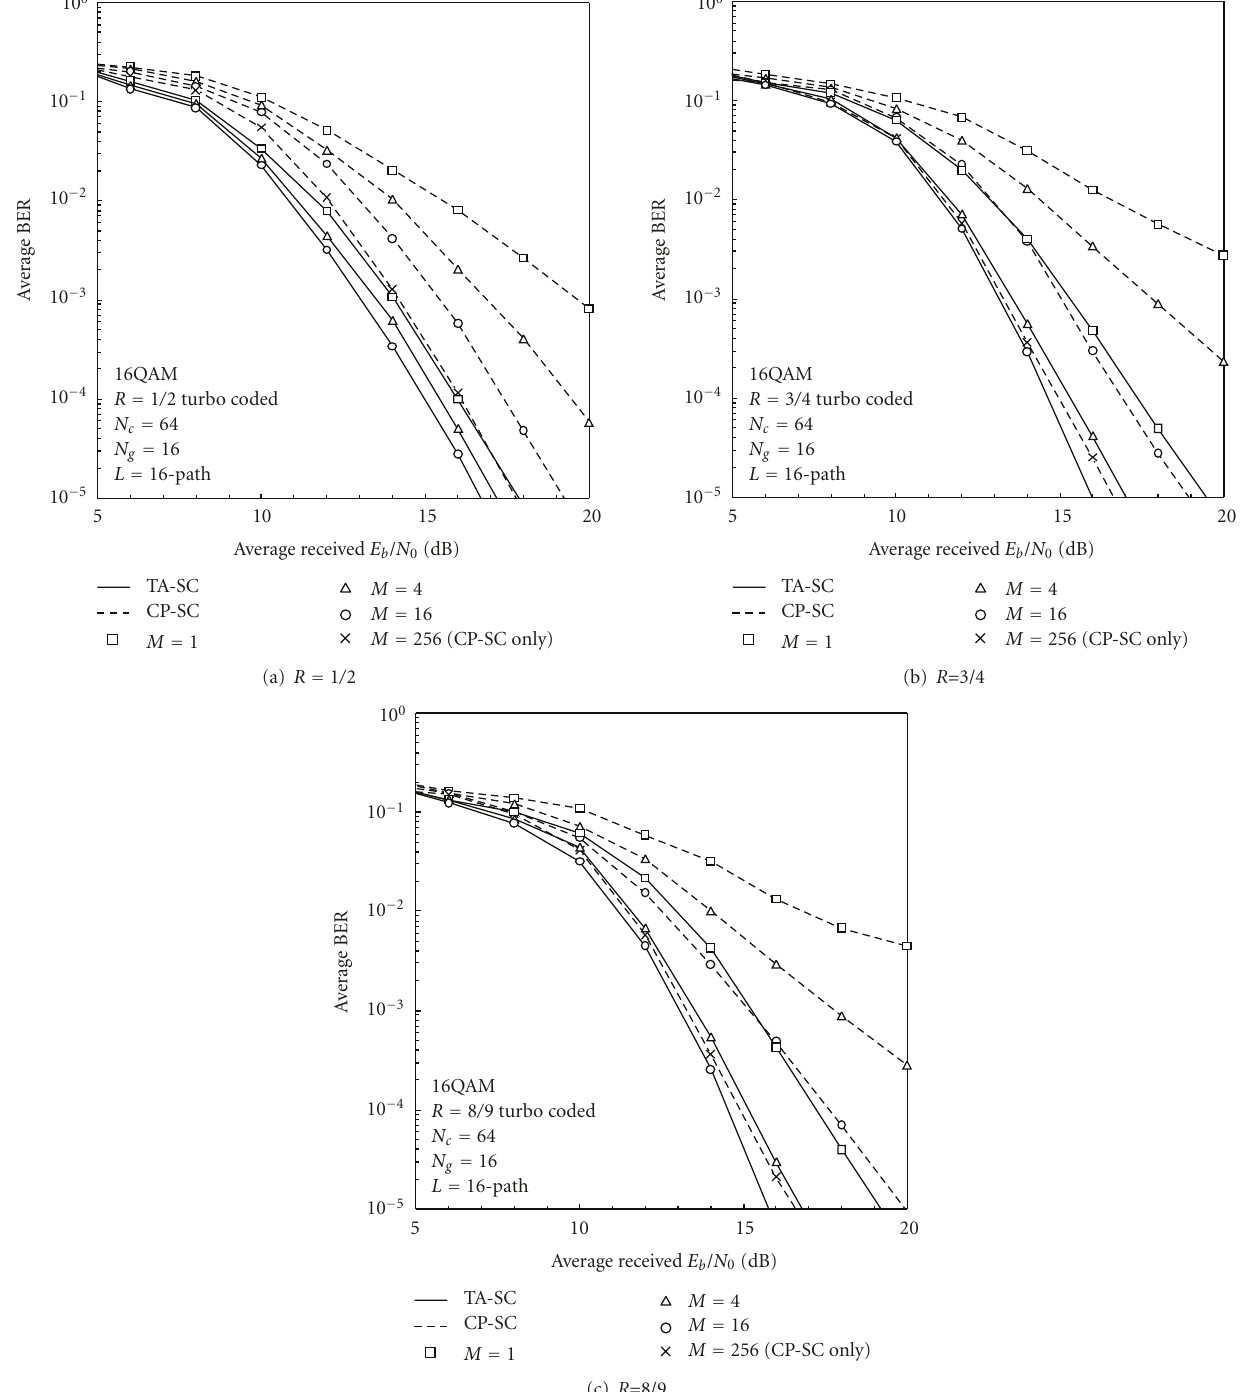
Figure 9: Average BER performance (turbo